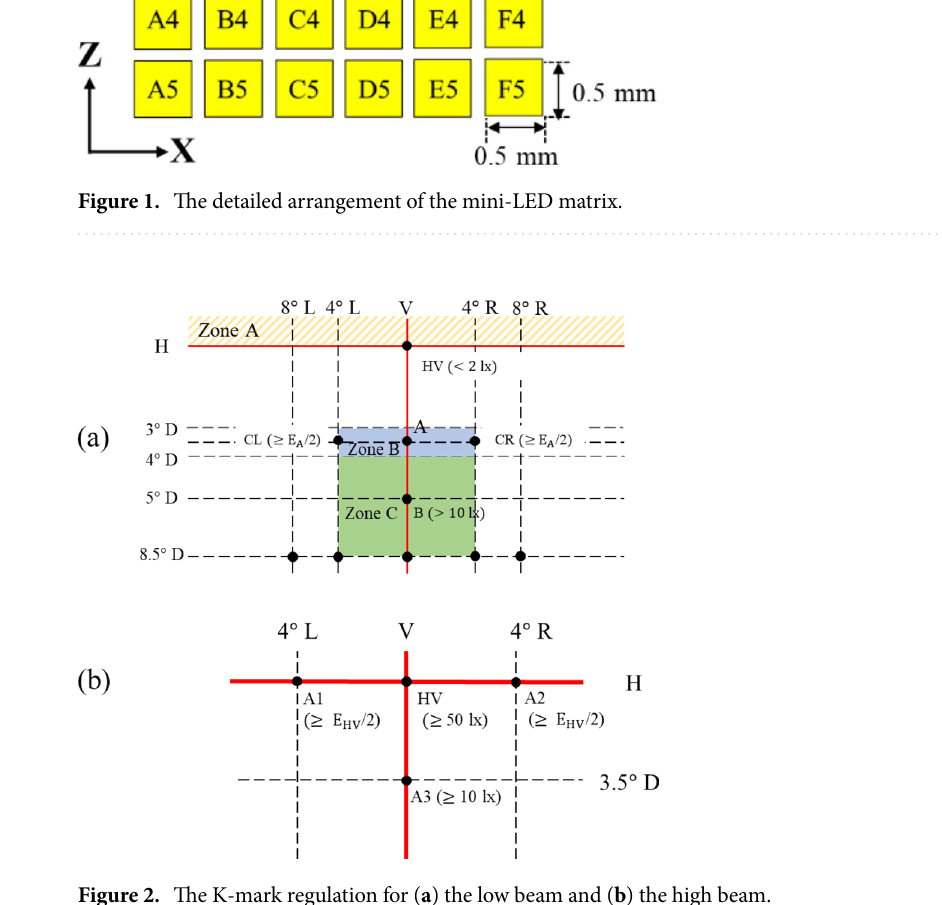
Figure 2. The K-mark regulation for ( a ) the low beam and ( b ) the high